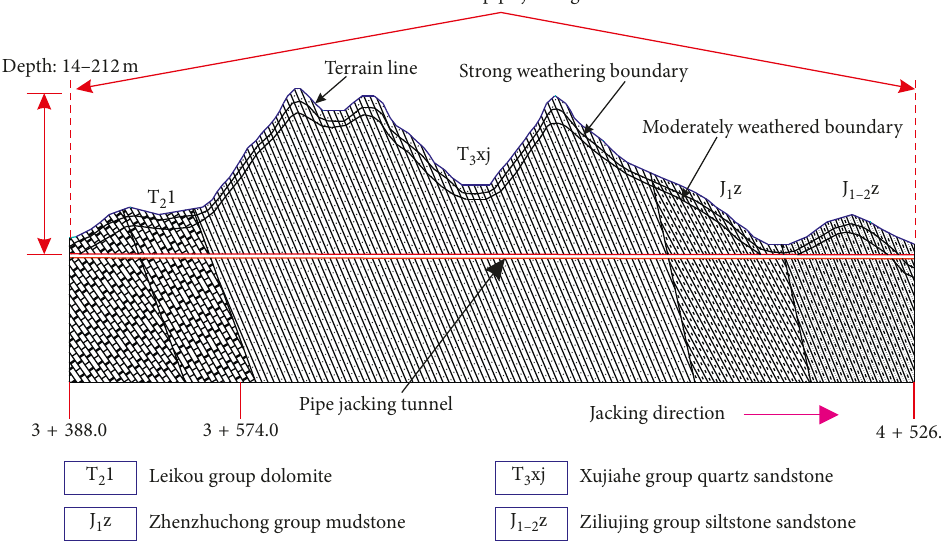
Figure 1: Plan view and geological section of the No. 2 pipe jacking tunnel. Table 1: Comprehensive rock mass properties of the Guanjingkou pipe jacking